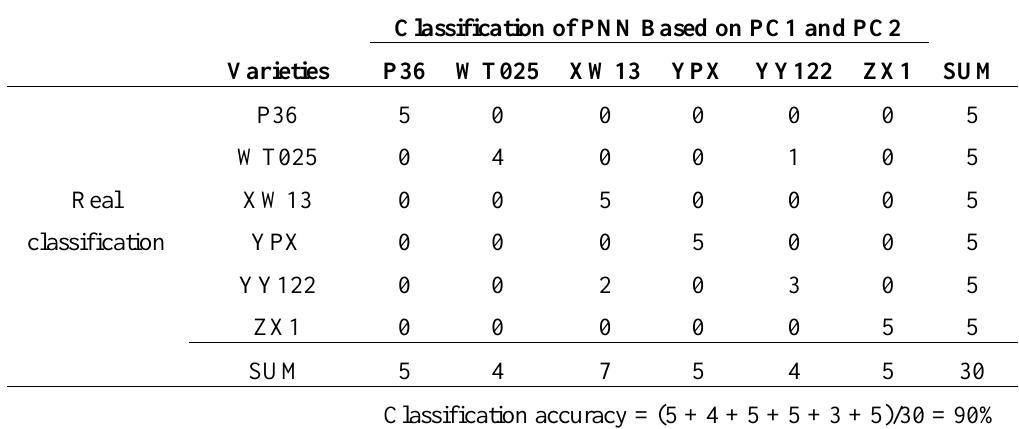
Table 3. Classification result of the test set (PC1 and PC2) using PNN (Spread = 4 × 10 −5 ). Classification of PNN Based on PC1 and PC2 Varieties P36 WT025 XW13 YPX SUM P36 Real classification